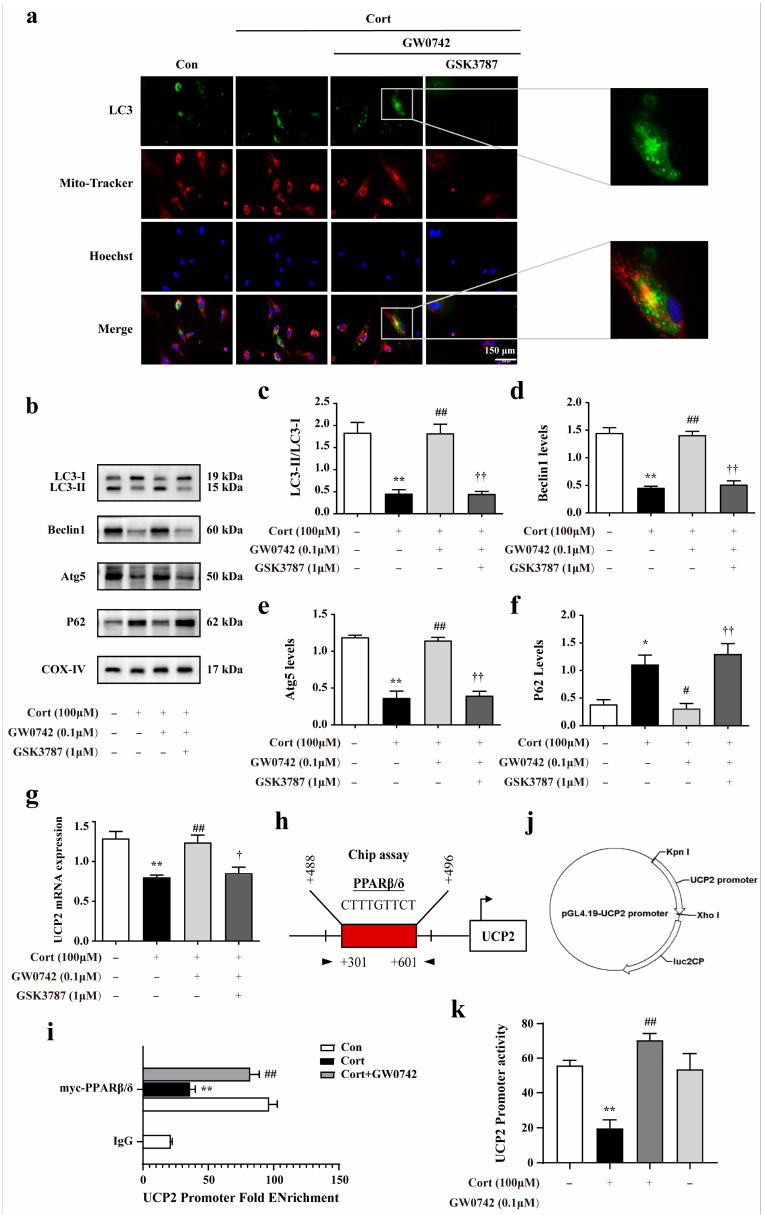
Figure 4. GW0742 enhances mitophagy in astrocytes via upregulating the expression of